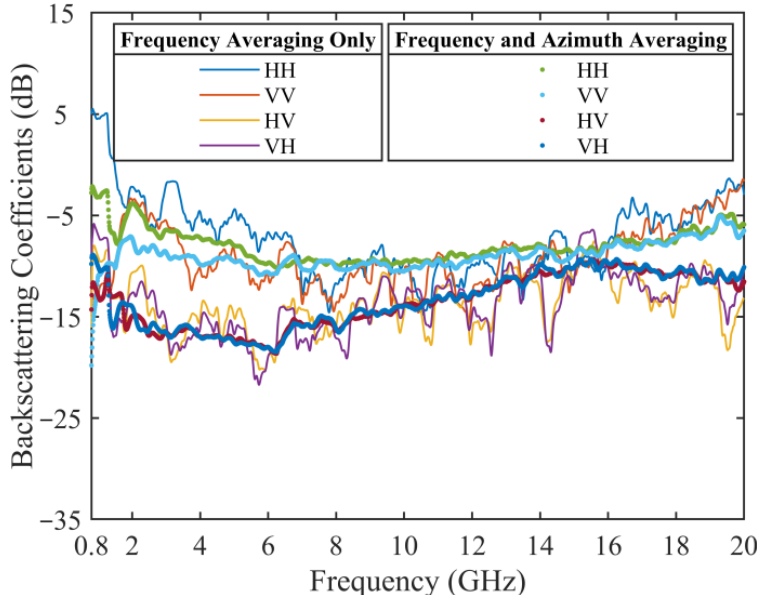
Figure 16. Measured backscattering coefficient results for rice field Scene 2 as a function of frequency after frequency averaging only and both frequency and azimuthal averaging at an incidence angle of 40°.